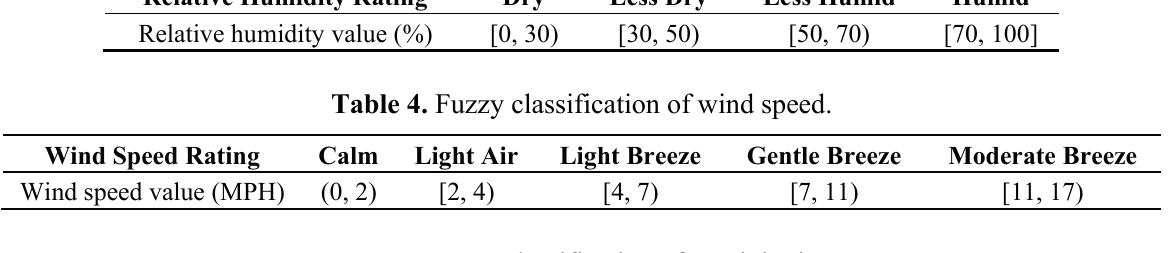
Table 5. Fuzzy classification of precipitation.